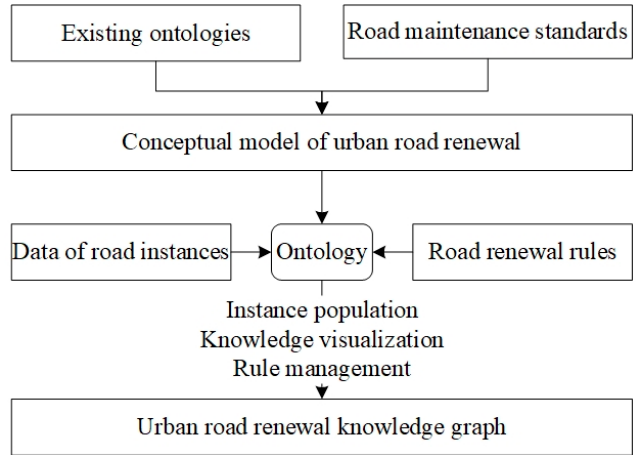
Figure 1. Implementation of knowledge graph for urban road renewal.